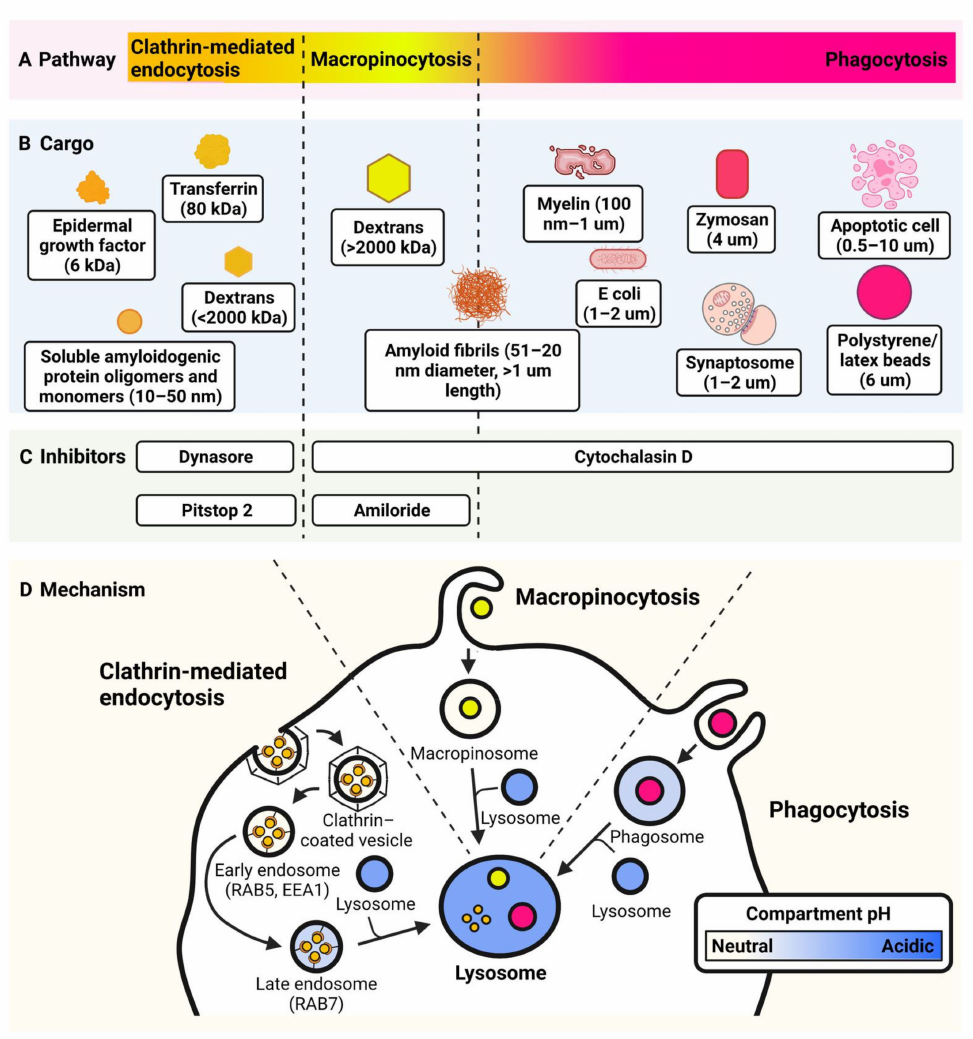
Figure 2. Schematic of methods for assaying endocytosis and phagocytosis. ( A , B ) Pathways and cargoes of endocytosis. The size of particle determines the pathway utilised, indicated by colour on the schematic. Clathrin-mediated endocytosis (<120 nm) is shown in orange. Macropinocytosis (>200 nm) is shown in yellow. Phagocytosis (>500 nm) is shown in pink. ( C ) Inhibitors used in endocytic assays. ( D ) Mechanisms of endocytic pathways. Blue indicates relative acidity of compartments. The lysosome is pH 4.5–5.0. Endosomal protein biomarkers are also